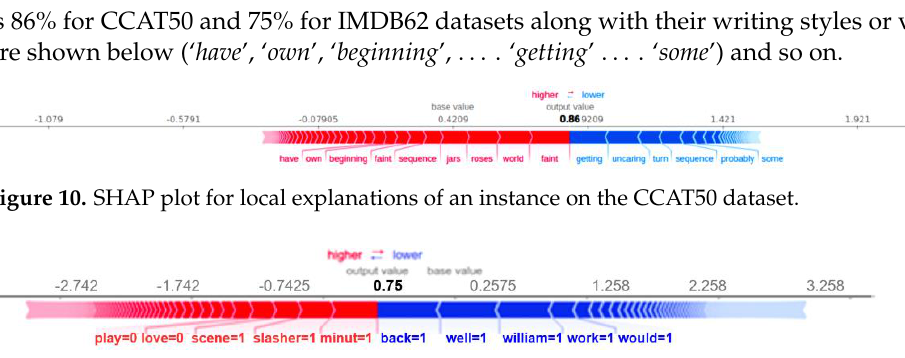
Figure 11. SHAP plot for local explanations of an instance on the IMBDB62 dataset.